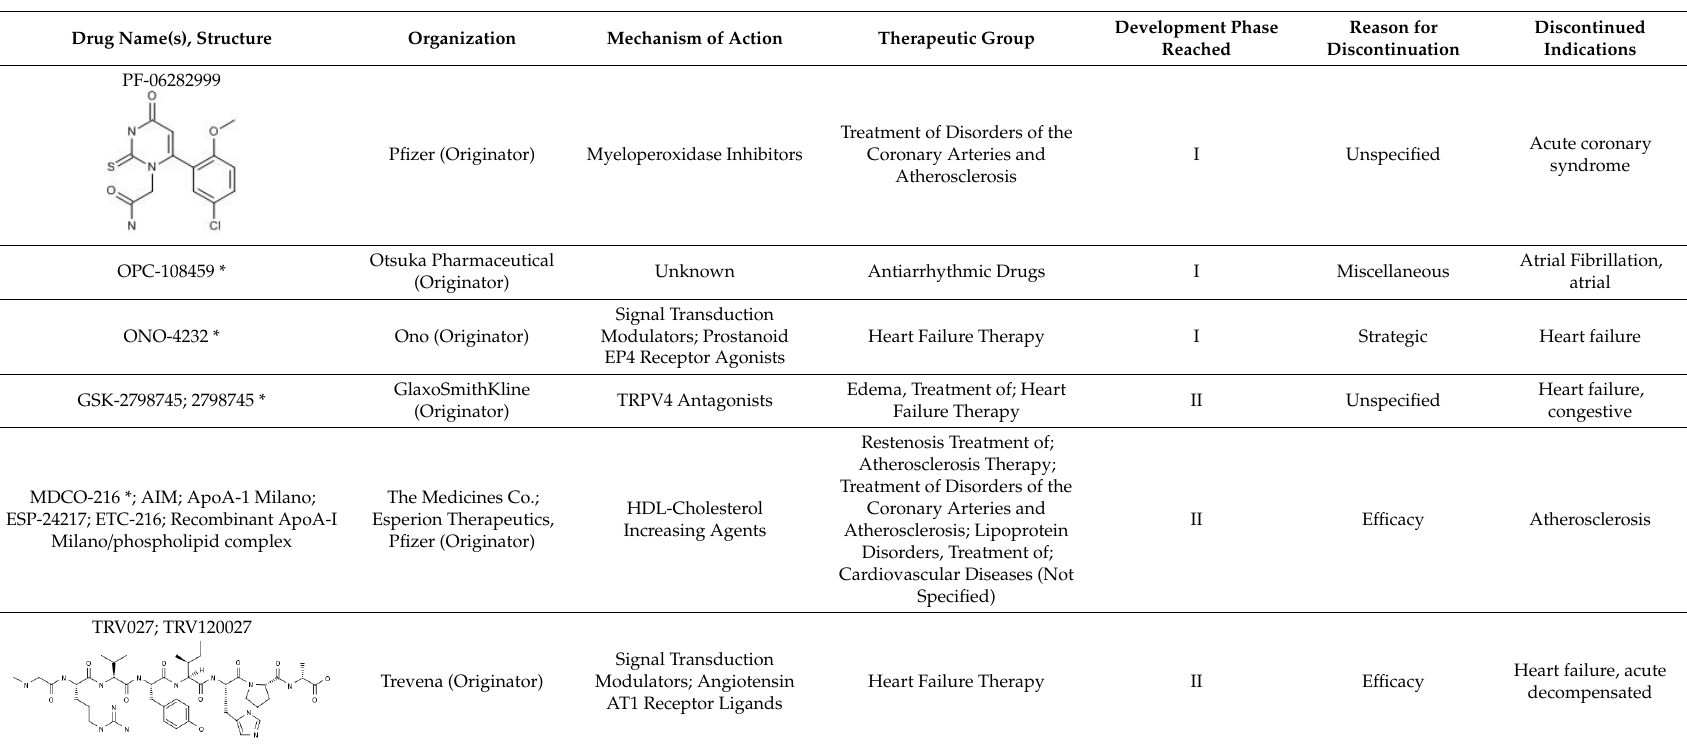
Table 1. Discontinued drugs for the treatment of cardiovascular disease from 2016 to 2018.